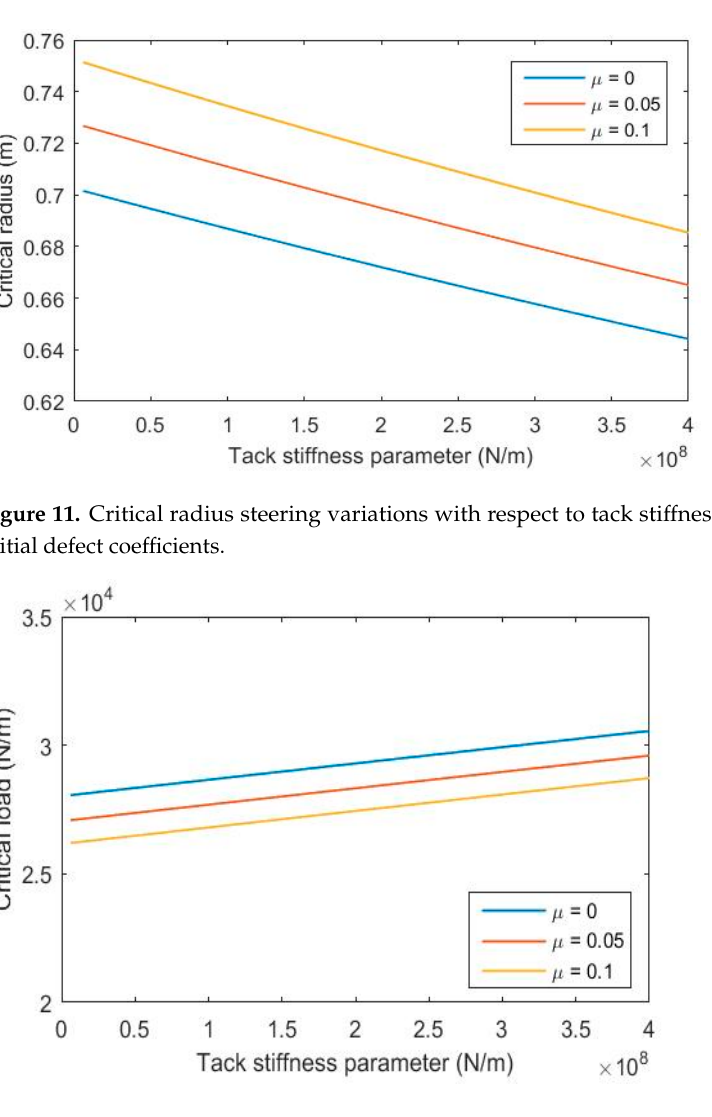
Figure 10. The variations of critical radius versus different plate aspect ratios and initial defect coefficients.